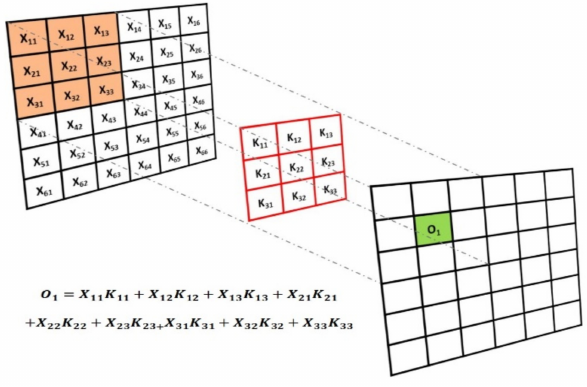
Figure 6. Schematic diagram of image convolution operation.